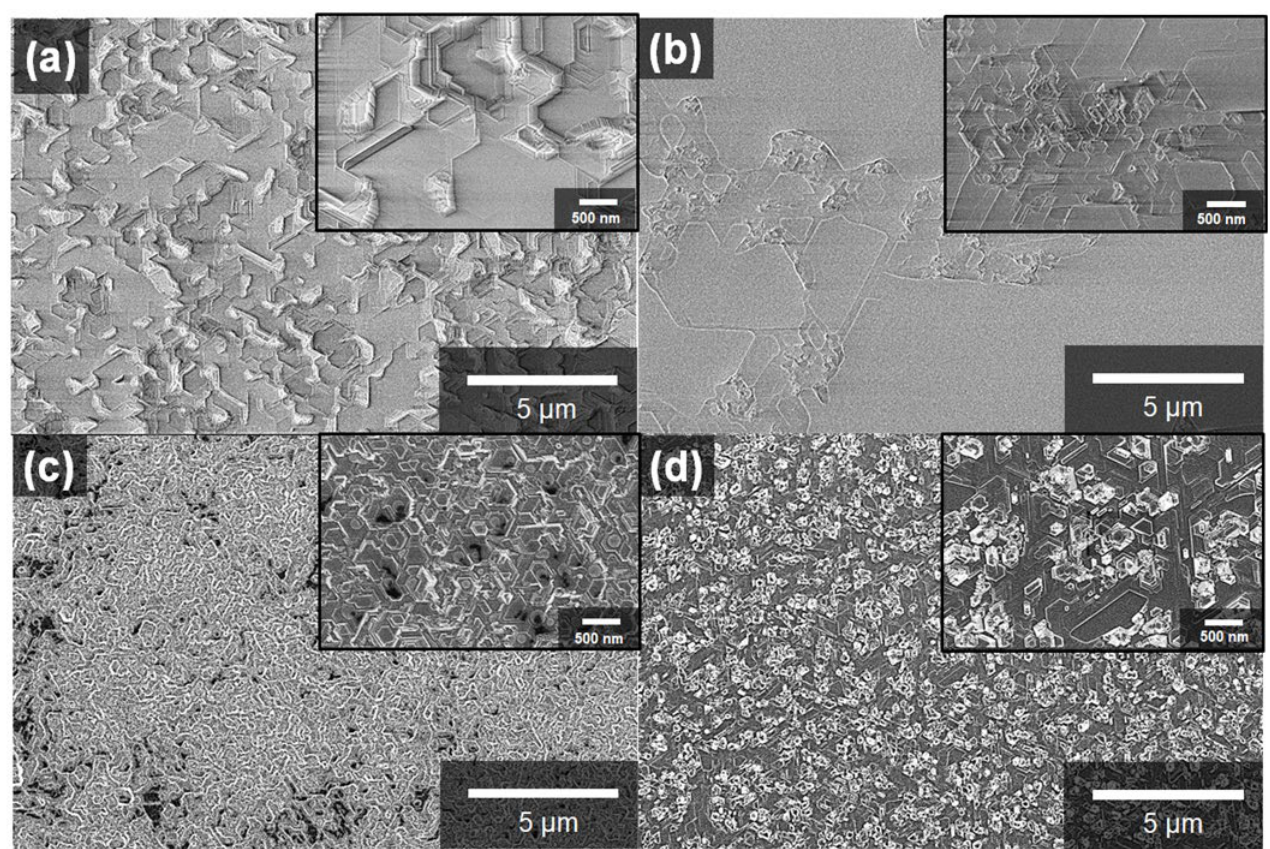
Figure 3. Scanning electron microscope images of the surfaces for the beryllium oxide layers created by the two-step spin-coating method depending on the content ratio: ( a ) 0.5:1, ( b ) 1:1, ( c ) 2:1, and ( d ) 3:1 citric acid and beryllium sulfate.